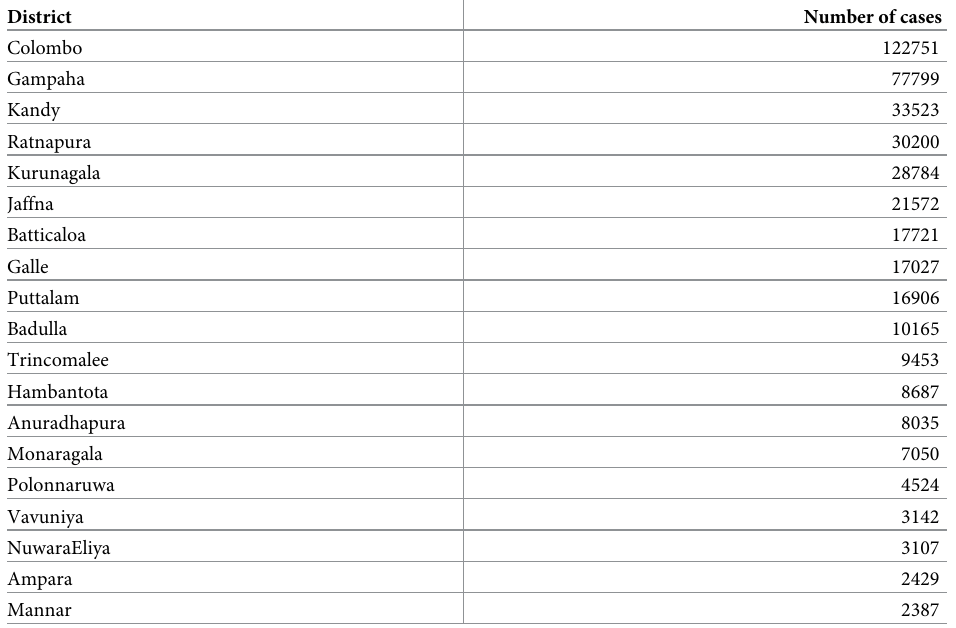
Table 1. The number of dengue cases reported during the considered period of time in each district. The table is arranged from descending order from highest number of reported cases to the lowest.